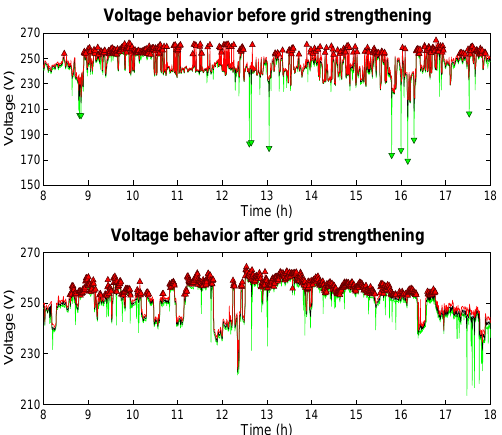
Figure 3. Voltage behavior before ( above ) and after ( below ) the grid strengthening from 8:00 to 18:00. The red line represents the maximum voltages; the black line represents the medium voltages and the green line represents the minimum voltages. Swells are marked with red upwards ‐ pointing triangles and dips are marked with green downwards ‐ pointing triangles.